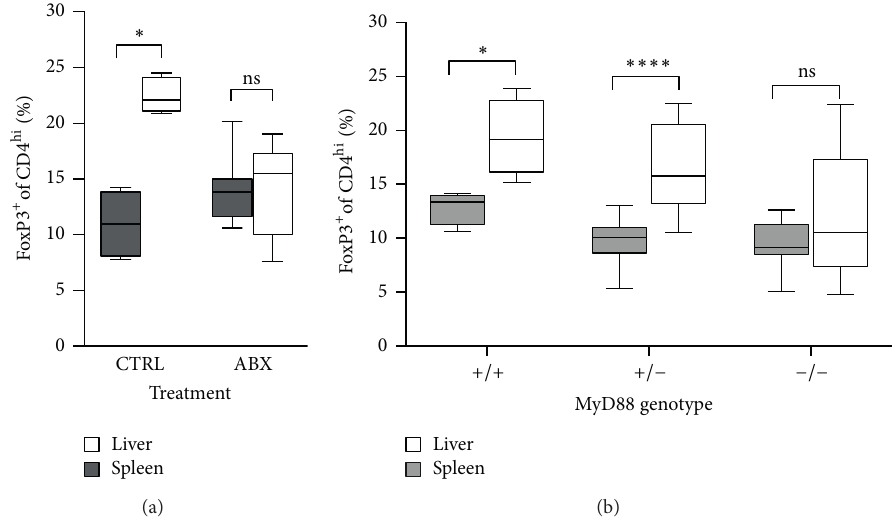
Figure 5: The increased frequency of FoxP3 + CD4 + cells in postnatal liver is blocked by treatment with antibiotics and depends on MyD88. (a) Pregnant C57Bl/6 females were treated continuously with a cocktail of oral antibiotics from two weeks of gestation until pups were 8-9 days of age, at which time spleen and liver NPC were isolated and FoxP3 + CD4 + cells were measured ( 𝑛 = 13 mice). Control mice are untreated C57Bl/6 background pups of the same age ( 𝑛 = 4 mice). Statistical analyses used the nonparametric Mann-Whitney test. (b) Liver and spleen FoxP3 + CD4 + cell frequency data are shown for 8- to 9-day-old littermate Myd88 +/+ mice , Myd88 +/− mice, and Myd88 −/− mice. 𝑁 = 8 to 13 mice per time point. Myd88 mice were on a mixed BALB/c × C57Bl/6 background, but littermates were used, minimizing background effects. Statistical analyses used the nonparametric Mann-Whitney test.